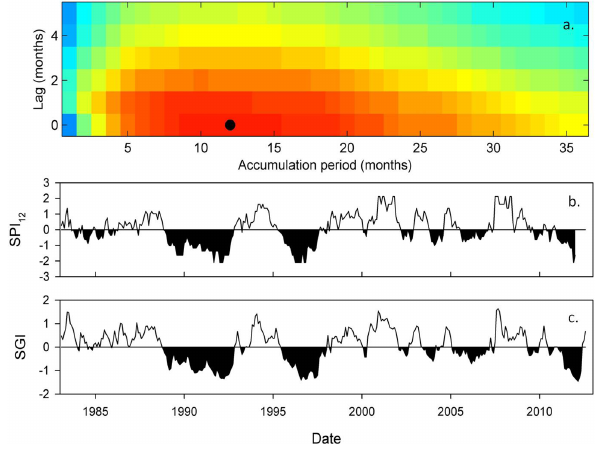
Figure 2. (a) SPI–SGI correlation as a heat map, (b) mean SPI 12 time series and (c) mean SGI time series for all 74